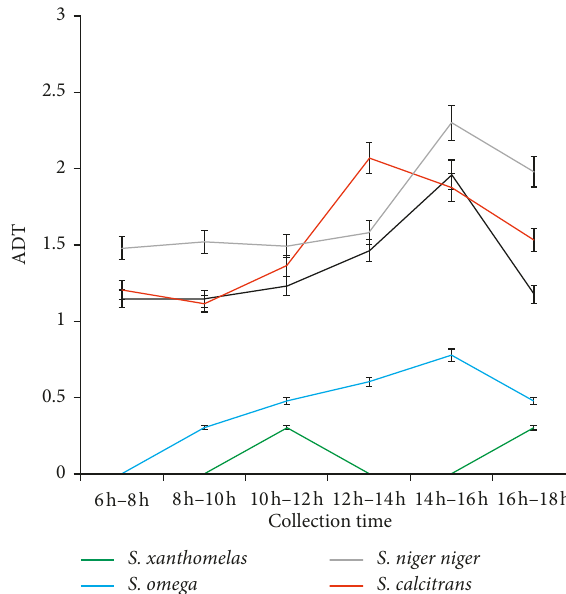
Figure 4: Daily activity rhythms of Stomoxys spp. in the dry season (March 2017). ADT: trap apparent